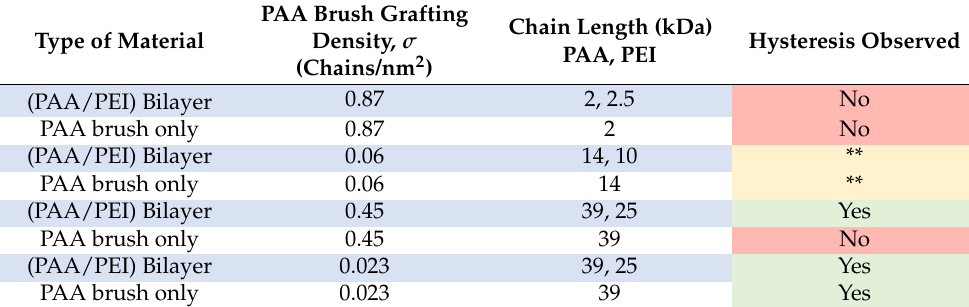
Table 2. Summary of experimental findings for PAA brushes and LbL bilayers (PAA/PEI) for various chain lengths and grafting densities. ** and the yellow color indicate intermediate cases where slow approach to equilibrium suggests that hysteresis would be present at short times (less than 5 min) but becomes small at longer times (tens of minutes).